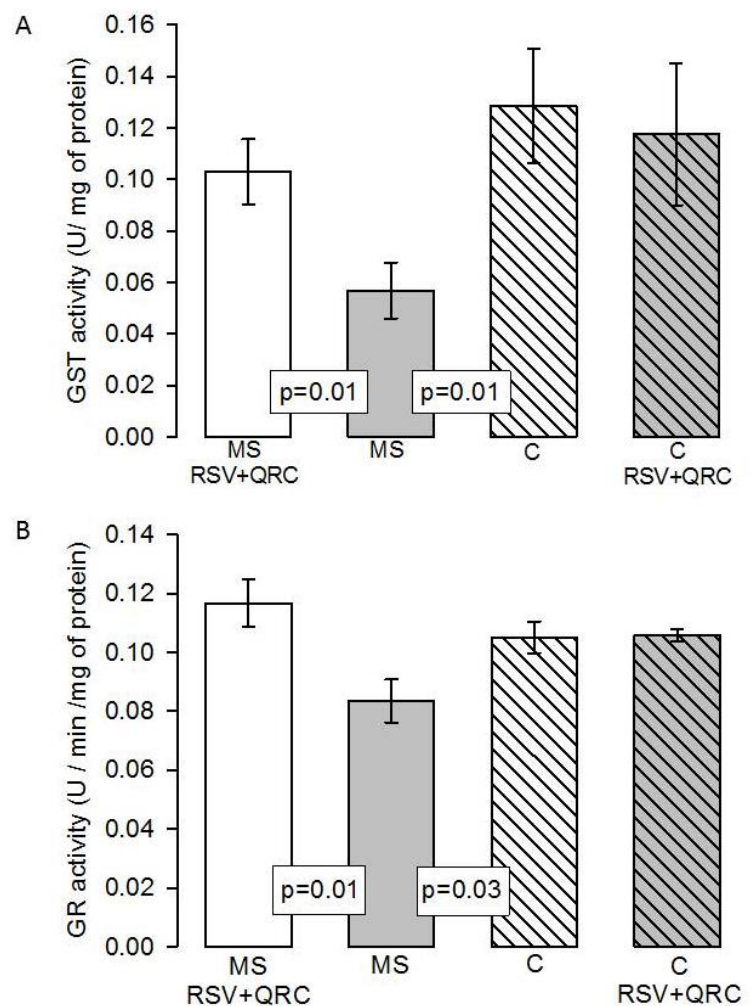
Figure 6. Effect of the treatment with natural compounds on Glutathione- S -transferase activity ( A ) and Glutathione Reductase ( B ) activity in liver homogenate. Data are means ± SE, n = 8 each group. Abbreviations: MS = metabolic syndrome, C = control, RSV = resveratrol, QRC = quercetin.